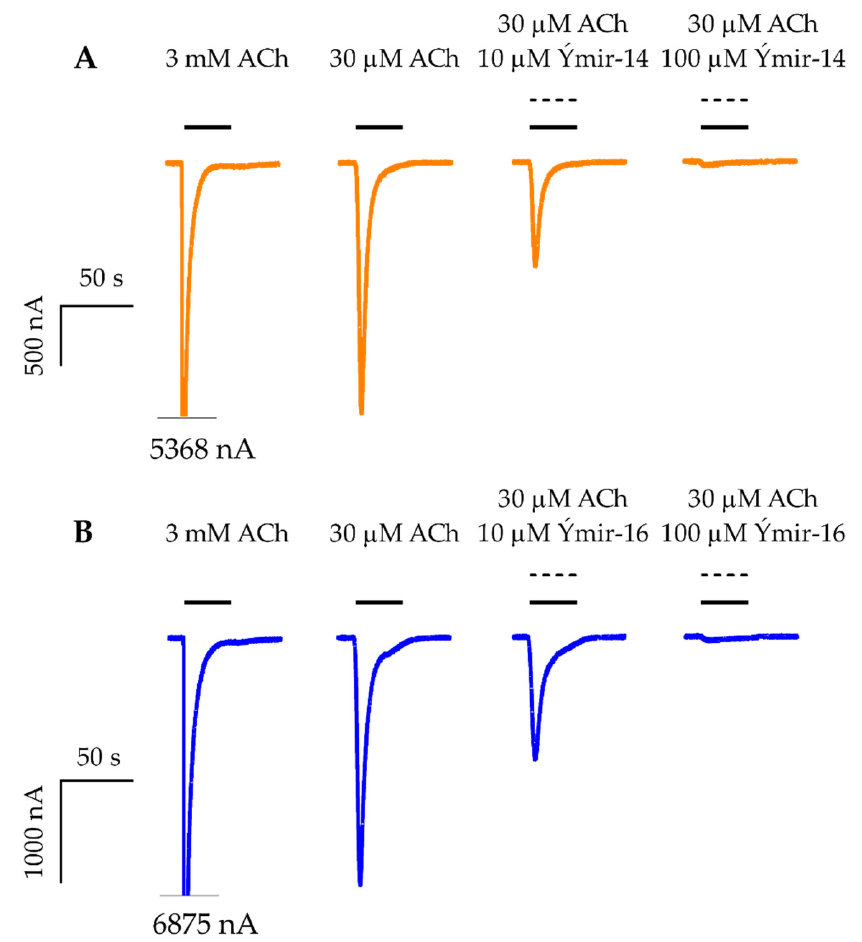
Figure 8. Evaluation of compounds as antagonists. Representative current traces for ACh and 10 and 100 µ M Ý mir-14 ( 19 ) ( A ) and Ý mir-16 ( 21 ) ( B ) co-applied with 30 µ M ACh at α 7 nAChRs expressed in Xenopus oocytes. Cells were subjected to two-electrode voltage-clamp electrophysiology experiments where the oocyte membrane potential was clamped at − 60 mV. The representative traces were baseline subtracted. Bars above the traces represent the application periods and the respective test solution concentrations are indicated above them. Note that the majority of the washing periods (3 min) between each trace is omitted in the figure.